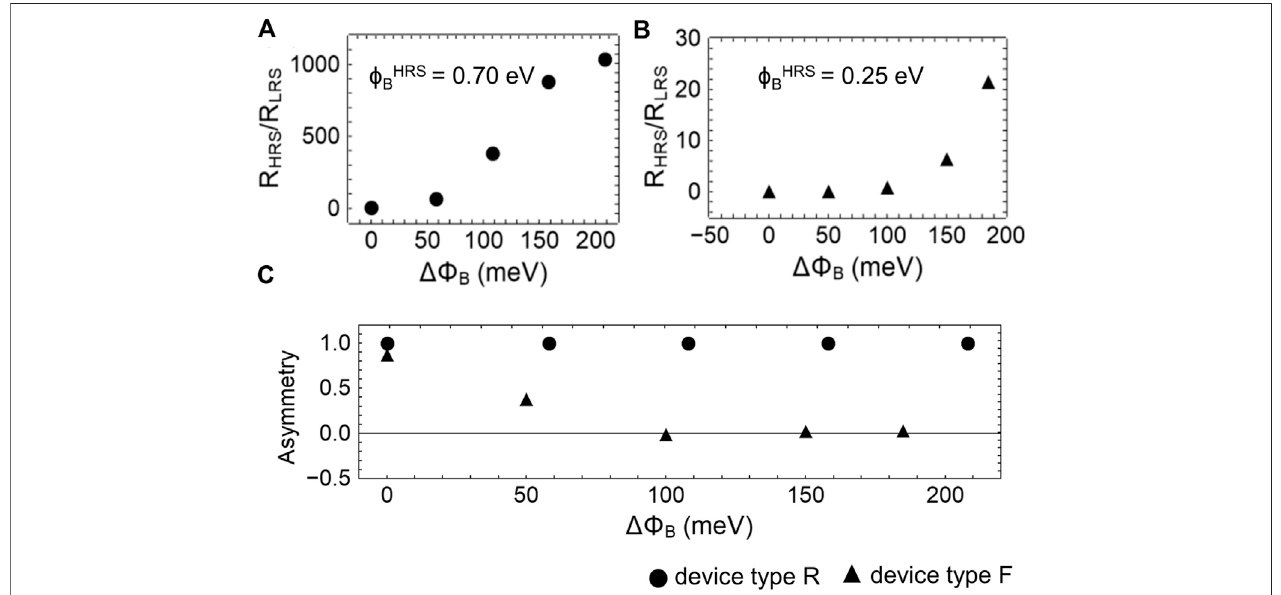
FIGURE5| In fl uenceoftheSchottkybarrierheightlowering ΔΦ B onthedeviceresistance: theresistancevalueasafunctionofSchottkybarrierloweringfortypeR devices (A) and type Fdevices (B) . Φ HRS B isthe inertial Schottky barrier height for therespective Rand Ftype device. (C) Asymmetry asafunctionof thebarrier lowering. Strong asymmetric characteristics are observed in device R (circle) within 200 meV in the barrier lowering, while the asymmetry was destroyed in device F (triangles) at 100 meV barrier lowering.